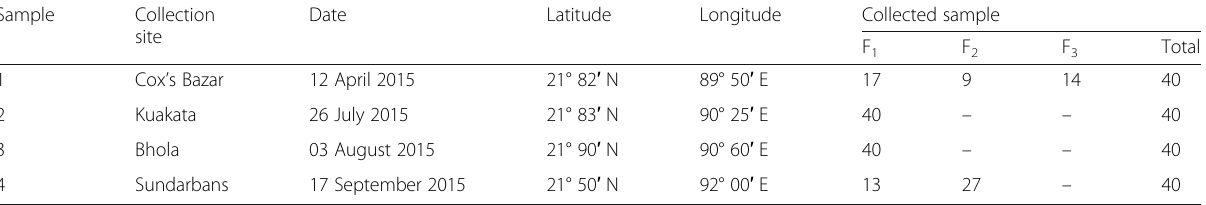
Table 1 Summary of A. clupeoides samples (sampling sites, dates, geographical locations, and numbers of the collected fish sample) used in morphometric analysis